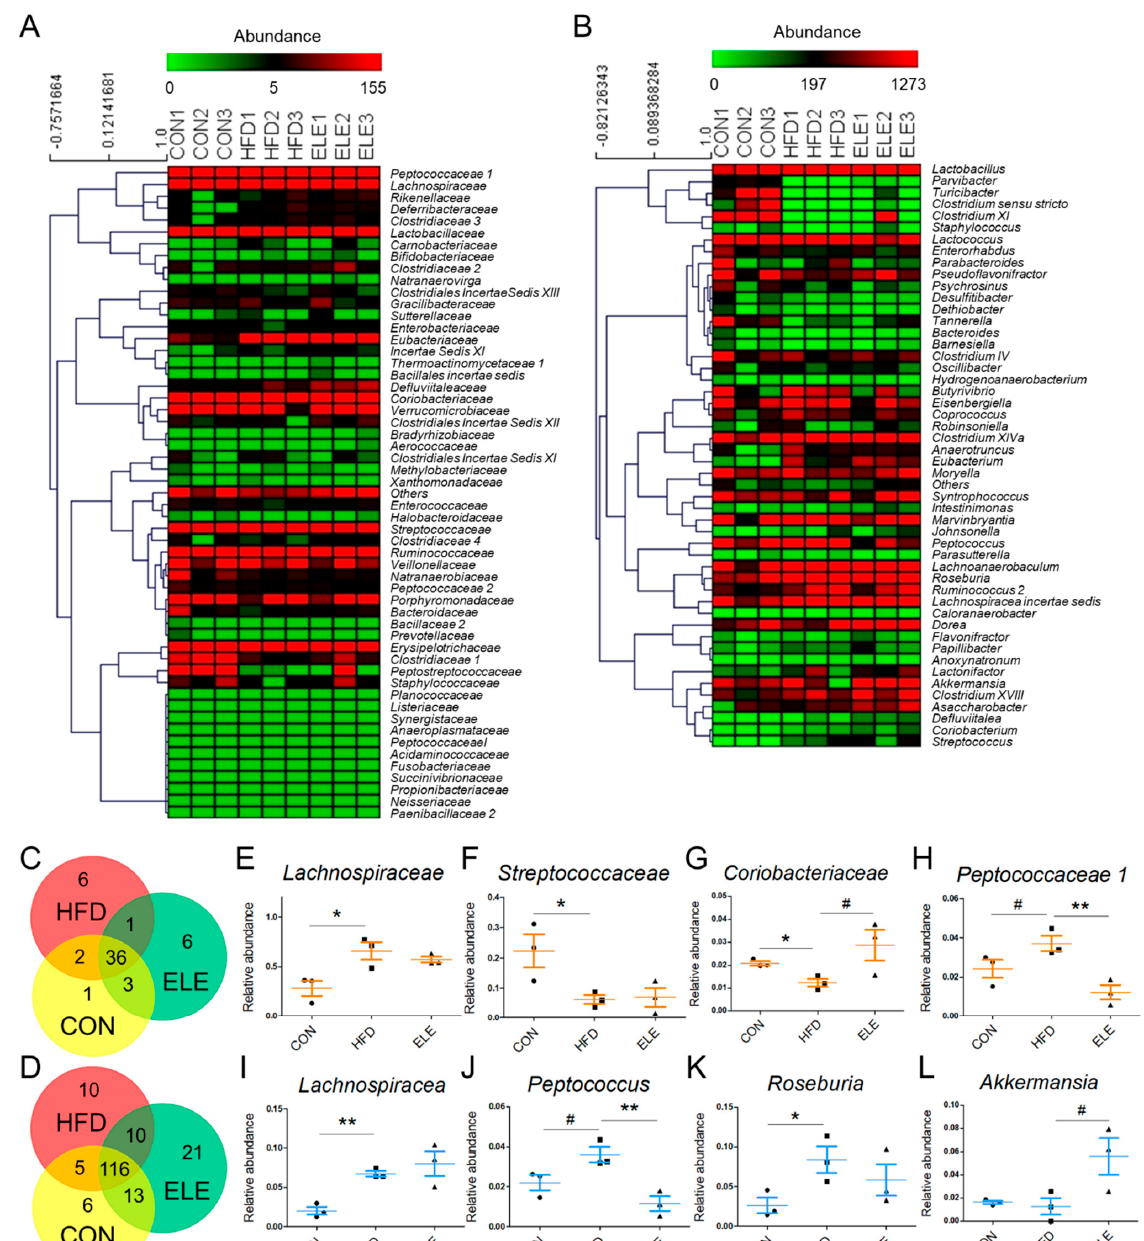
Figure 4. Relative abundance of families and genera from intestinal microbiota in different treatment groups. ( A , B ) Heat map of families ( A ) and the top 50 genera ( B ) with their relative abundances. ( C , D ) Venn diagram of families ( C ) and genera ( D ) in different treatment groups. ( E – L ) Relative abundances of Lachnospiracea ( E ), Streptococcaceae ( F ), Coriobacteriaceae ( G ), Peptococcaceae1 ( H ), Lachnospiraceae ( I ), Peptococcus ( J ), Roseburia ( K ), and Akkermansia ( L ). The results are shown as the mean ± SEM ( n = 3). # p < 0.1; * p < 0.05; ** p < 0.01 vs. HFD group (assessed using one-way ANOVA followed by Dunnett’s multiple comparisons).